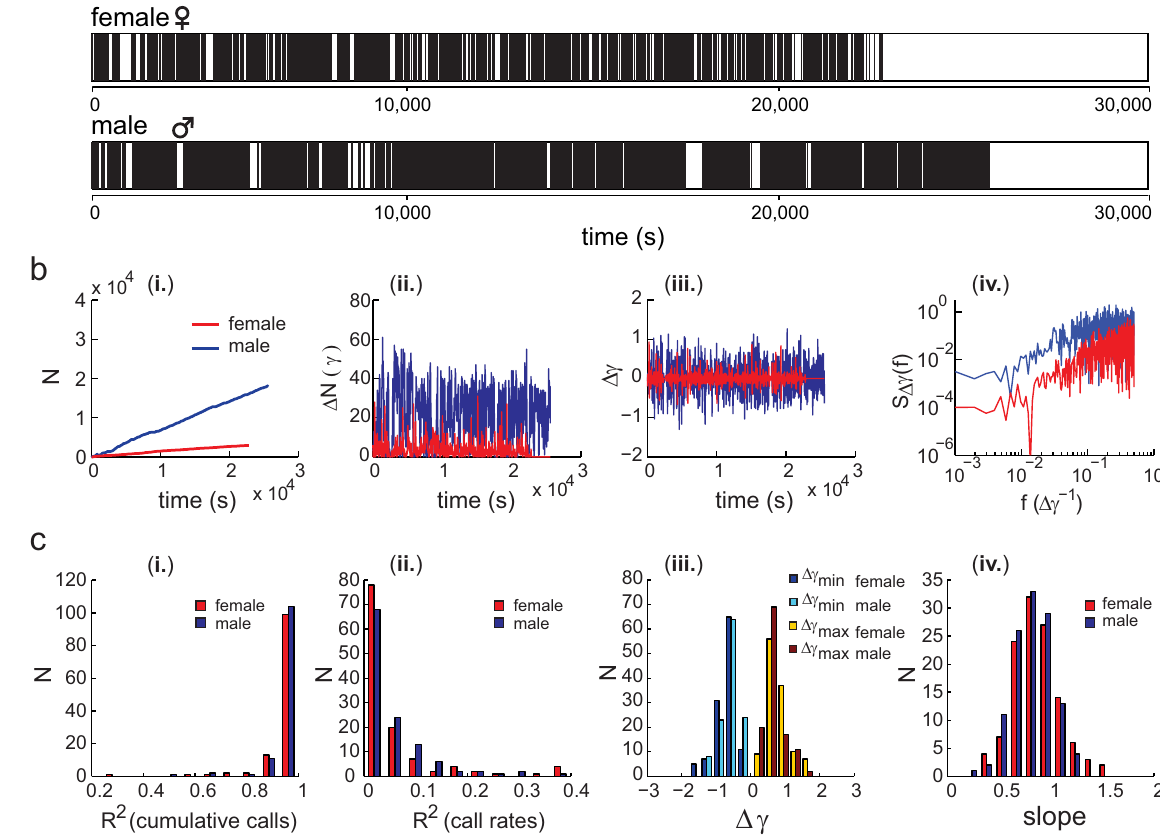
Figure 1. Calling activity of zebra finch pairs. ( a ) Example of a succession of calling interactions between a female (upper panel) and a male (lower panel) zebra finch. Vertical black lines corresponding to calling events are plotted as a function of time (in seconds). ( b ) Quantitative measurements of calling activity of one zebra finch pair (male in blue, female in red). ( b [i.]) Calling events were accumulated in a linear relationship over time; ( b [ii.]) the call rates ( γ ) corresponds to the number of calls ( Δ N) in a unit of time ( Δ t = 30 s); ( b [iii.]) The changes of call rates ( Δγ ) were plotted as the function of time; ( b [iv.]) The power spectra (S) and the frequency ( f ) of Δγ were positively correlated. ( c ) Statistical summary of all 22 tested zebra finch pairs including 119 days of calling activity. ( c [i.]) The density counts of the coefficient of determination (R 2 ) of cumulative calls (bin: 0.1). The values of R 2 are in range from 0 to 1. With increasing linearity of the data, R 2 approaches